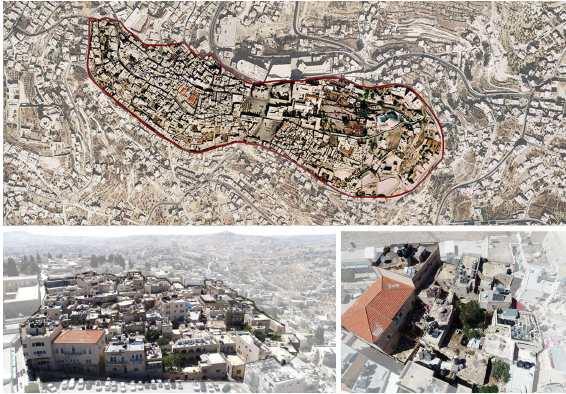
Figure 1: Bethlehem city center. The area identify by the documentation project and the morphology complexity of the historical neighborhood Al- Anatreh.